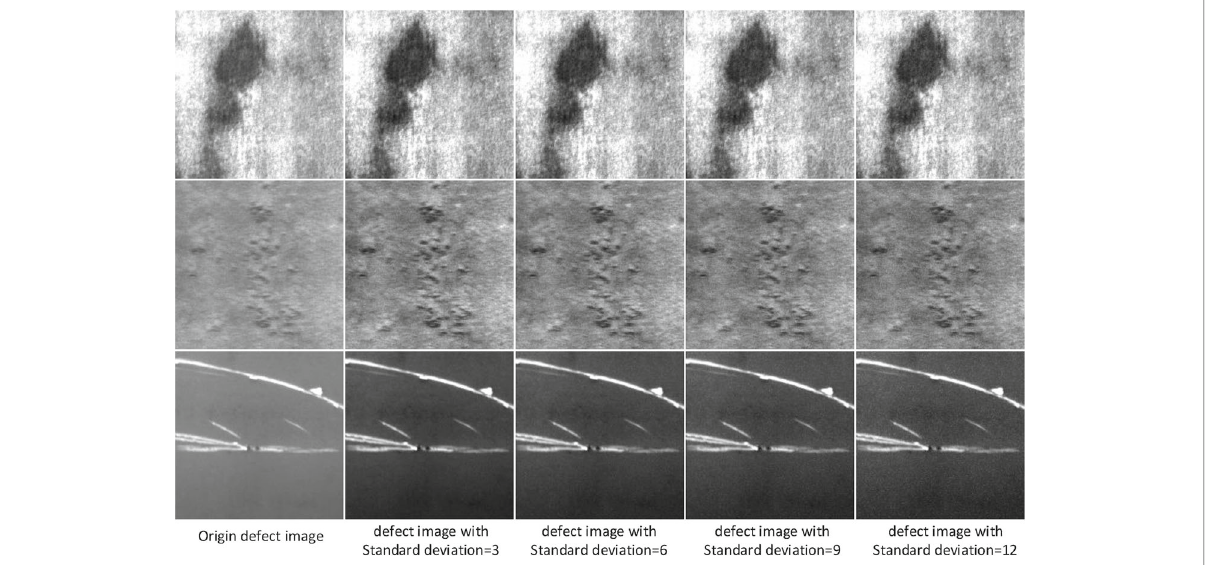
Fig. 7 Paired photographs of